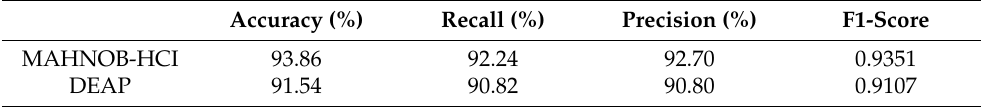
Table 6. Results of fusion of EEG and facial video clips using DCCA. Accuracy (%) Recall (%) Precision (%)